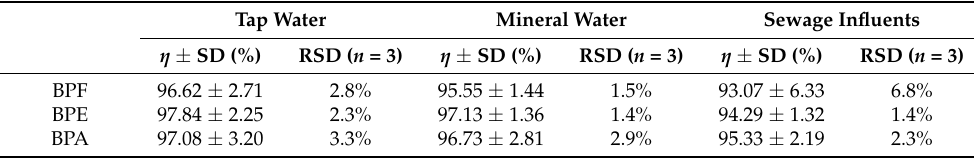
Table 1. The removal efficiency of m-DMI-MSNPs towards